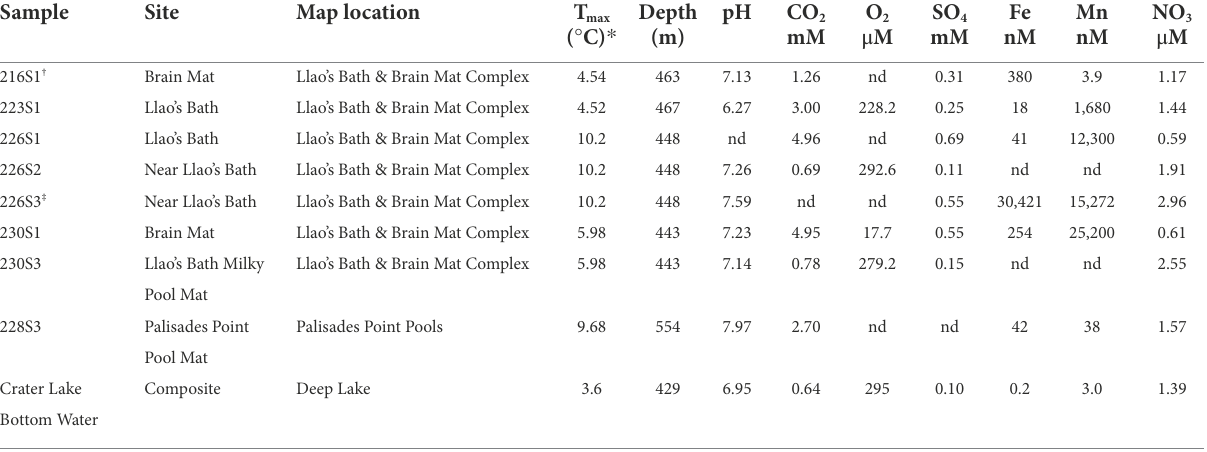
TABLE 1 Description of sample locations and geochemical profiles of mats and pool fluids. Data from Collier et al., 1991.